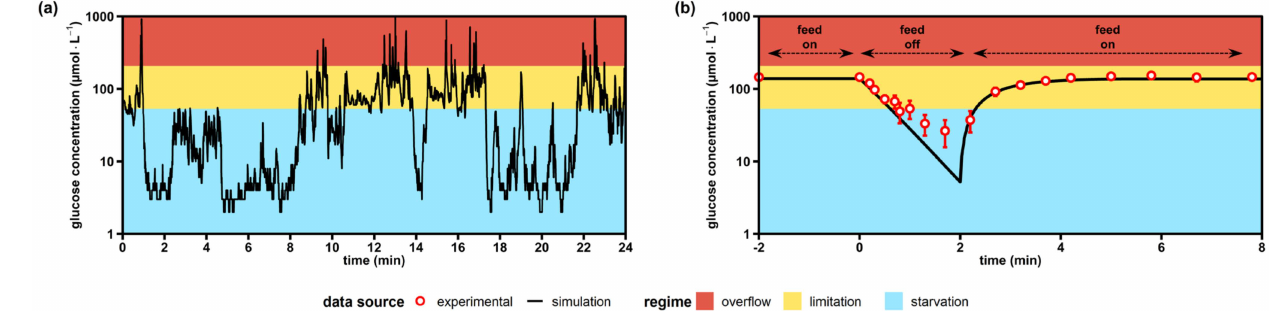
Figure 2. Simulated versus experimental glucose profiles experienced by yeast cells. ( a ) Exemplary lifeline of a single Saccharomyces cerevisiae trajectory recorded over 24 min during an industrial glucose-limited fed-batch process with a biomass concentration of 10 g · L − 1 . The lifeline was sim- ulated during the work of Sarkizi et al. [39], but not published. ( b ) Stimulus-response experiment as a glucose-limited chemostat with intermittent feed (this work). Extracellular glucose levels are the means ± standard deviation of six biological replicates (merged trends from adapted and non-adapted time series). All simulated values were computed using published glucose uptake ki- netics [51]. Overflow metabolism was assumed to start at glucose concentrations >207 µ mol · L − 1 [52] and starvation zones developed below 53 µ mol · L − 1 , where maintenance demands could not be covered anymore